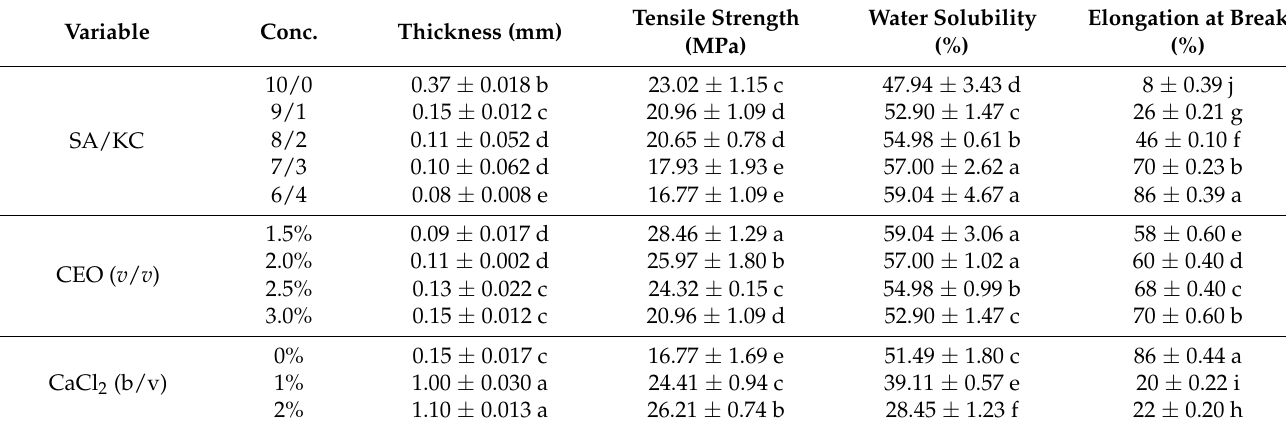
Table 1. Mechanical and physical properties of the SA/KC